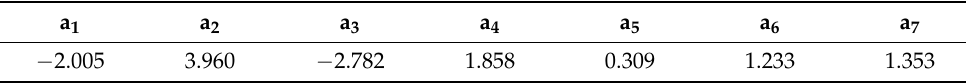
Table 3. Coefficient of the fitting formula (0–30 ◦